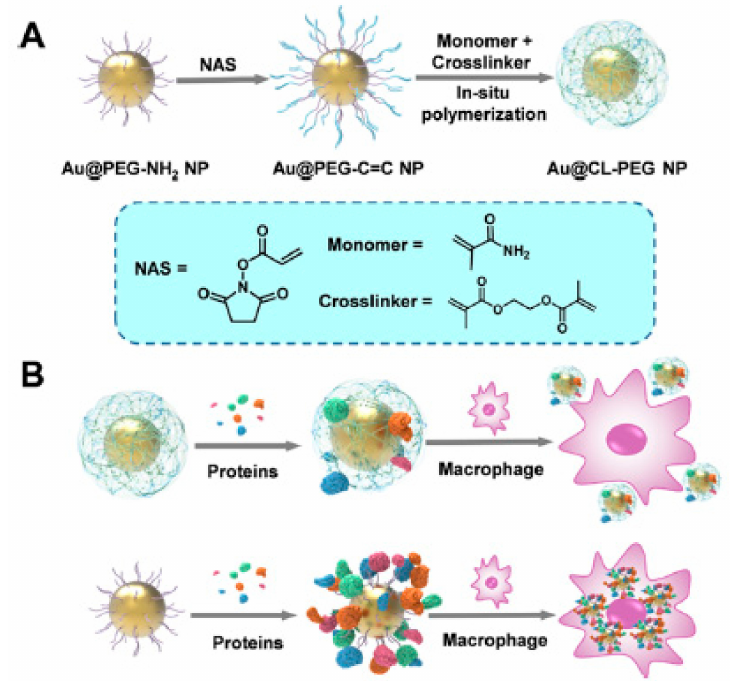
Figure 7. ( A ) Synthetic process leading to the generation of crosslinked PEG shells around Au nanoparticles, and ( B ) representation of the interaction between particles with crosslinked or linear PEG shells and proteins or macrophages. Reprinted with permission from reference [50]. Copyright (2019) American Chemical